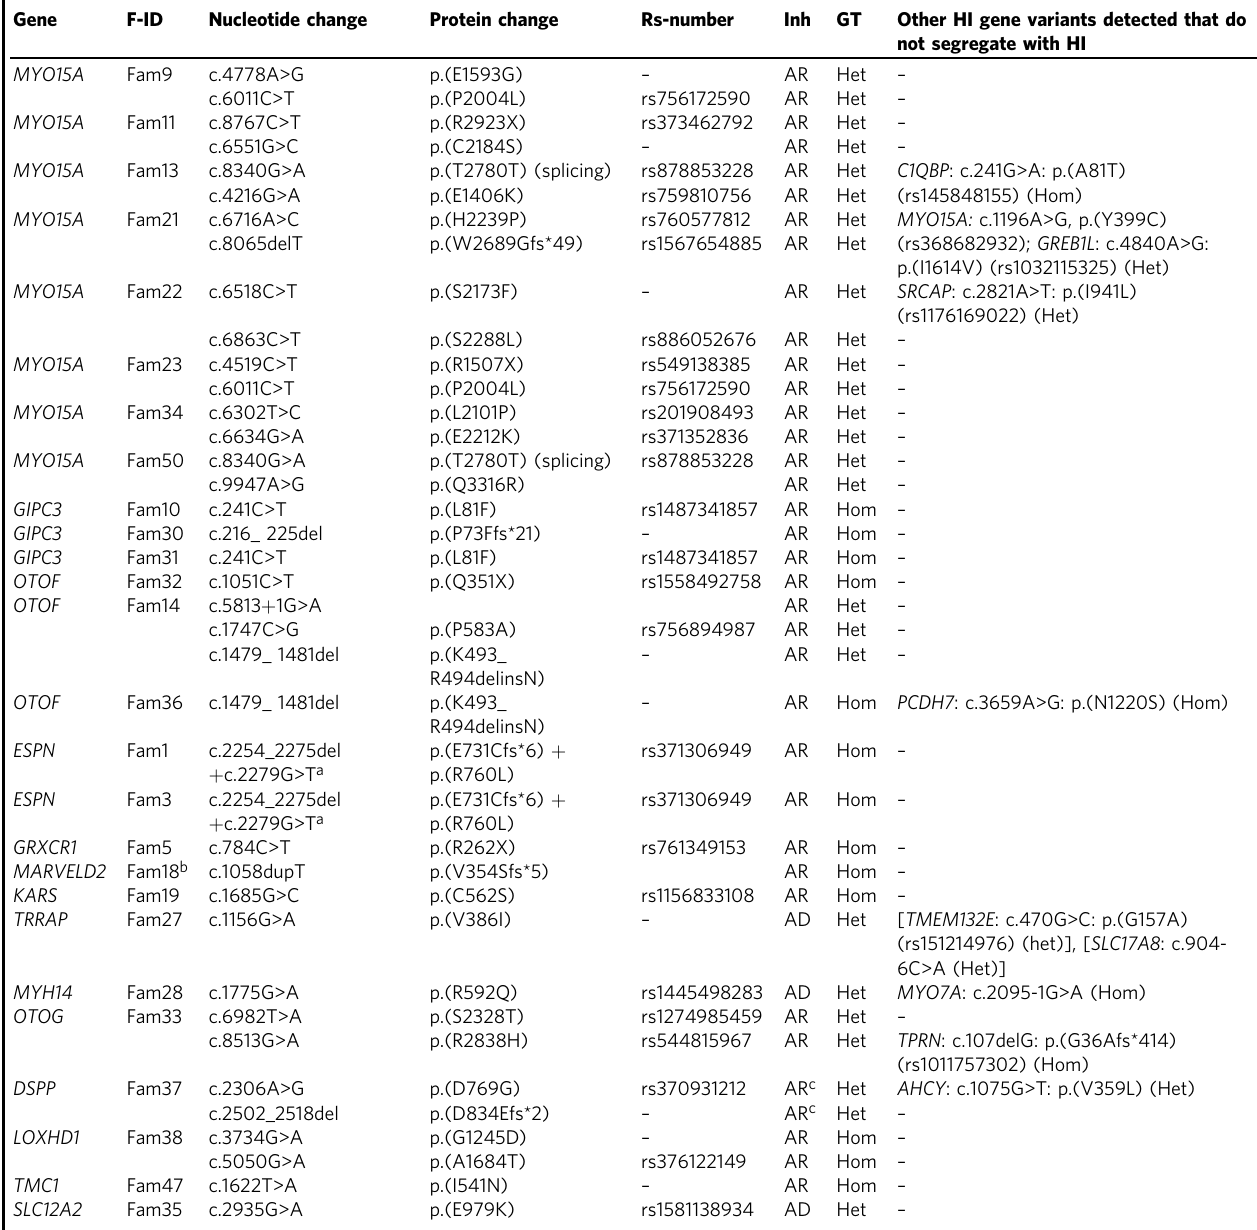
Table 1 Ghanaian families with variants in known genes underlying non-syndromic hearing